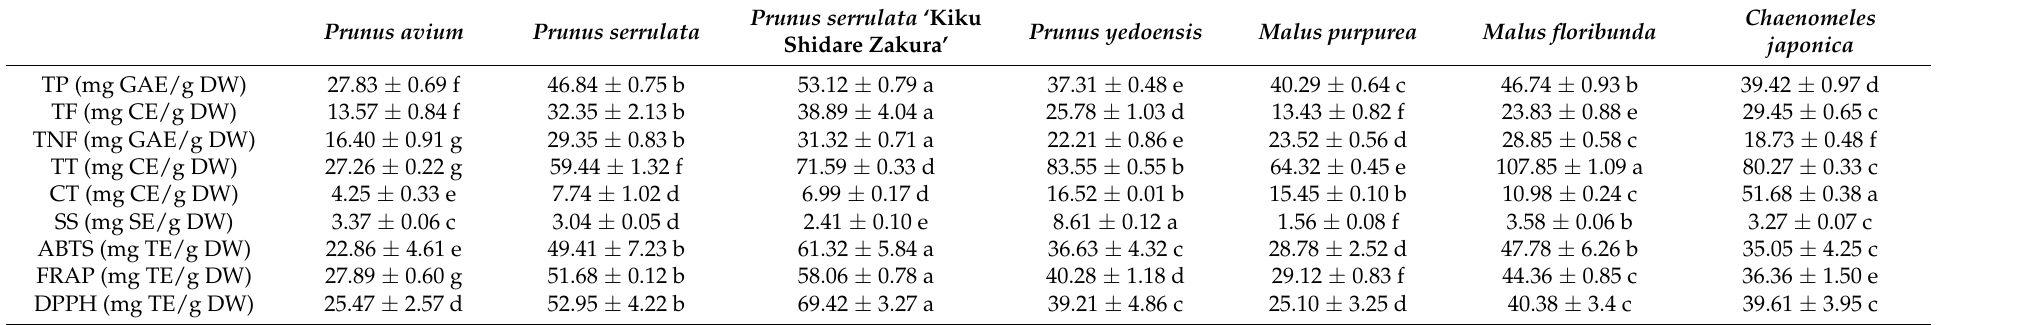
Values represent the mean ± standard deviation of three replicates. Different letters indicate a significant difference among the values in a row (ANOVA, Duncan test, p ≤ 0.05). GAE = gallic acid equivalent, CE = catechin equivalent, SE = sucrose equivalent, TE = trolox equivalent. Table 2. Concentration (mg/g DW ± SD) of the individual phenolic compounds in Rosaceae inflorescences. Prunus serrulata Prunus avium Prunus serrulata Prunus yedoensis Malus purpurea Malus floribunda ‘Kiku Shidare Zakura’